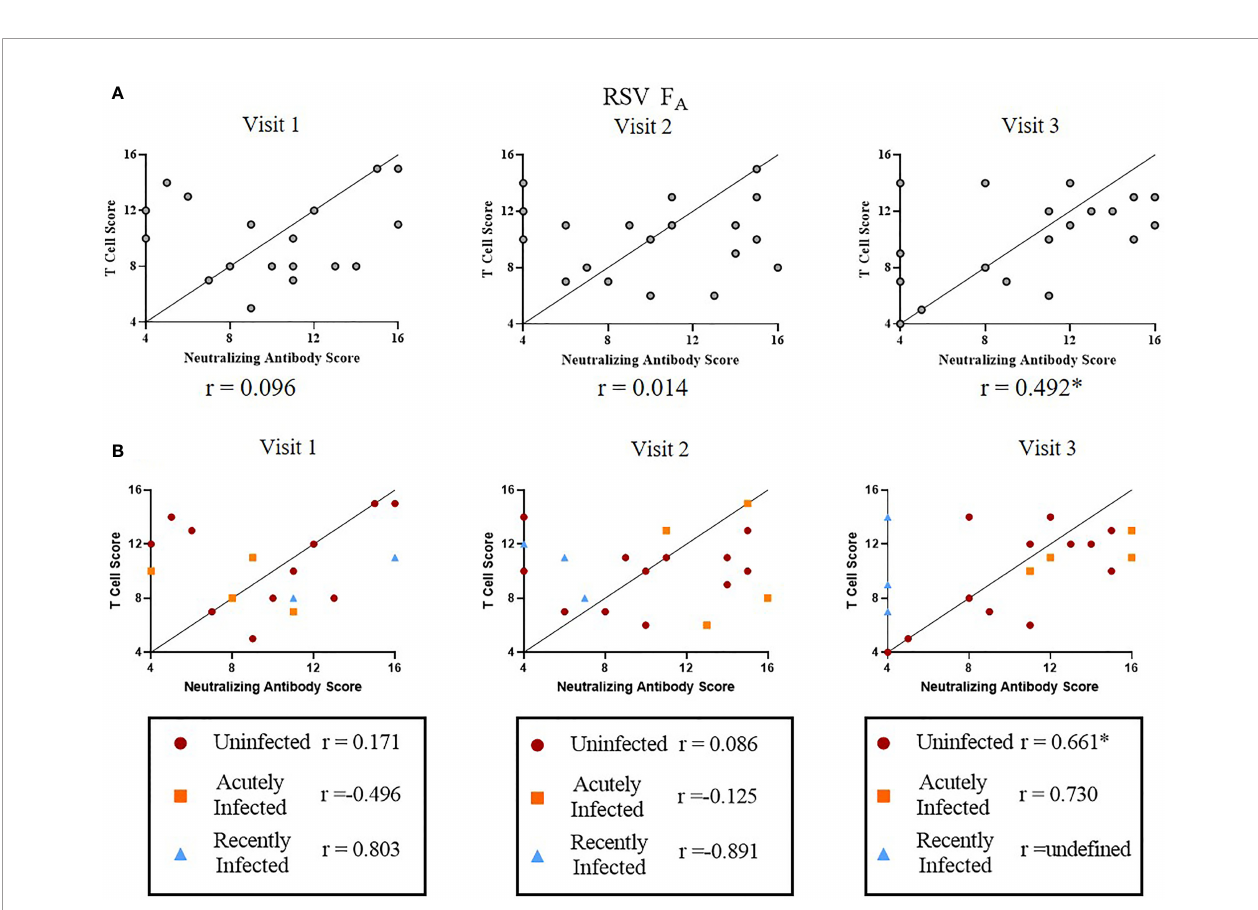
FIGURE 7 | Correlation between RSV F A T cell and neutralizing antibody responses. A signi fi cant linear relationship between T cell score and neutralizing antibody score is denoted by a correlation coef fi cient (r) with *P ≤ 0.05. (A) Correlation between RSV F A T cell score with neutralizing antibody score by study visit ( n = 19). (B) Correlation between RSV F A T cell scores with neutralizing antibody score by RSV infection status and study visit. Uninfected ( n = 12), acutely infected ( n = 4), or recently infected ( n = 3) individuals are shown.